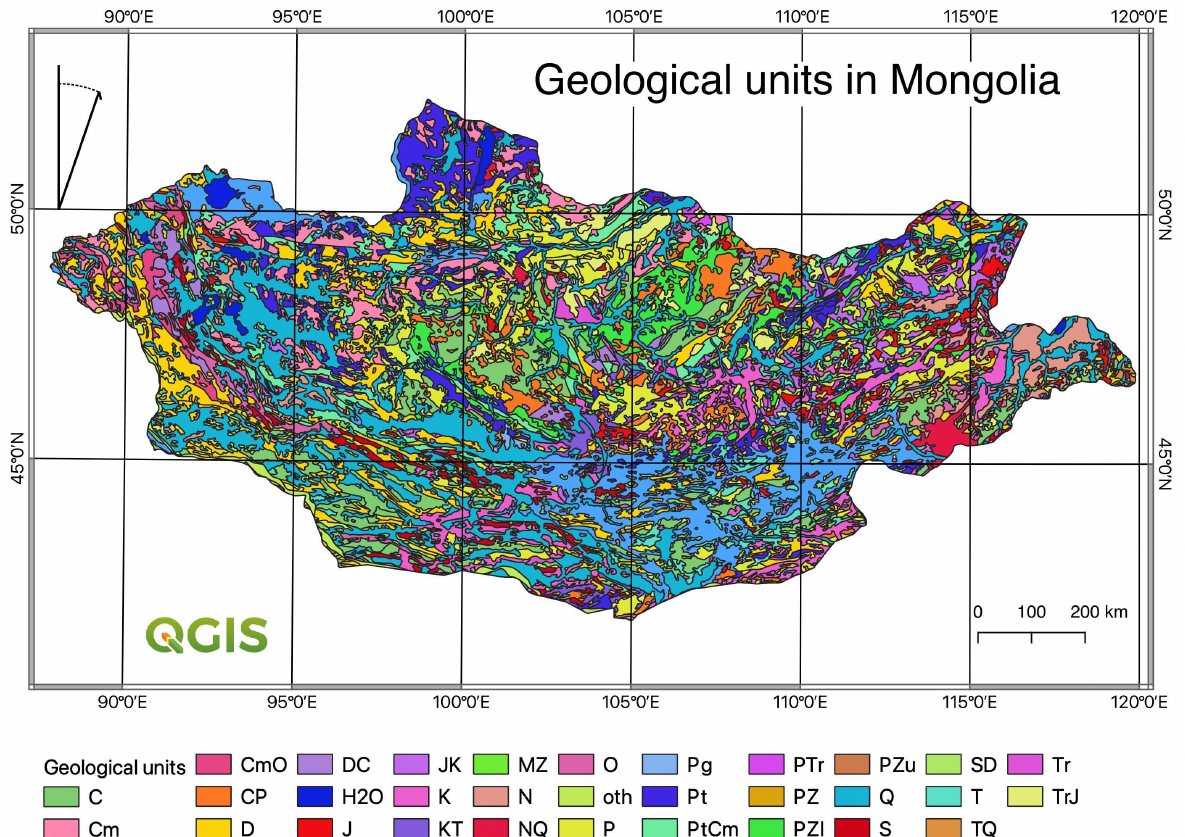
Fig. 3. Geologic units of Mongolia. Data: USGS geological survey. The geological map covers the whole area of Mongolia and encompasses the landscapes within the Central Asian fold belt, formed by a complex mixture of all age complexes of rocks, from the Precambrian undifferentiated up to Cenozoic blocks formed the geological structure of Mongolia. The modern geologic units have following major elements: 1) Paleozoic highlands form elevated blocks represented by lower (Cambrian, Cm) in south-west and central Mongolia, Ordovician (O), Silurian (S), Devonian and Carboniferous (D, C), Permian (P); 2) Mesozoic hill areas of country in the north (M) with the differentiated Triassic (Tr) and Jurassic (J) outcrops in rugged, dissected landscapes and Cretaceous (K); 3) The eastern area of Gobi Desert is characterized by the Cenozoic (Paleogene, Pg) complexes which are present along much of the eastern region. (3) Extensive highland areas infilled with late Paleozoic (Carboniferous and Permian, CP) sediments include the Khentii Mountains (orange colors). The Devonian (D) complexes are notable in the west of the country in the Altai Mountains (ocher color). W, SW and central regions are presented by Quaternary (Q) basalt fields forming gently rolling surfaces. Mapping: QGIS. Source: